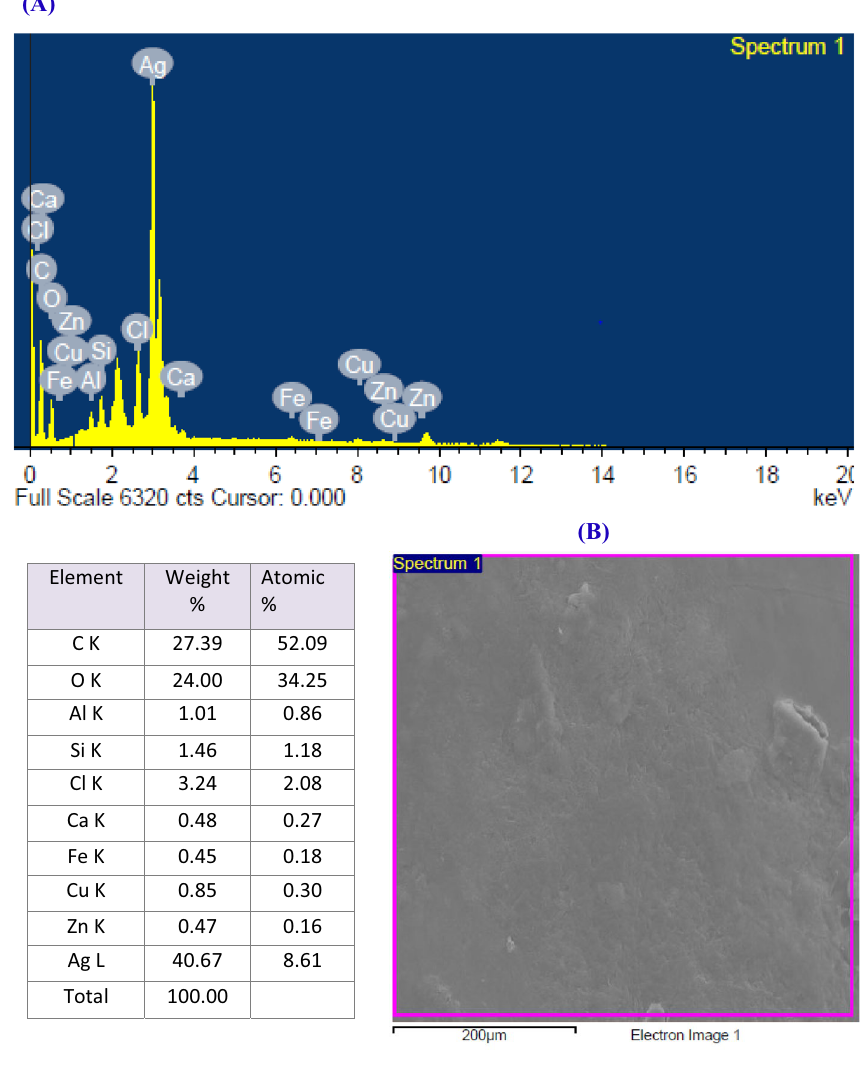
Figure 4. Energy-dispersive X-ray (EDX) spectrum of the biosynthesized OG-AgNPs recorded revealing peak approximately near 3 keV confirming the presence of silver ( A and B